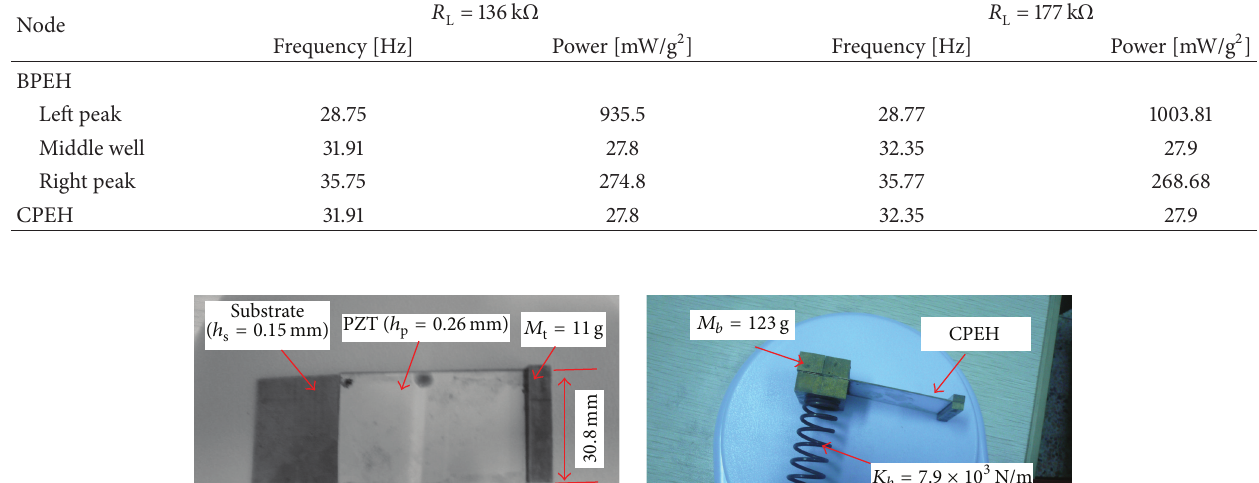
Table 2: Analytical results of BPEH with two different load resistances when 𝑎 = 20 .